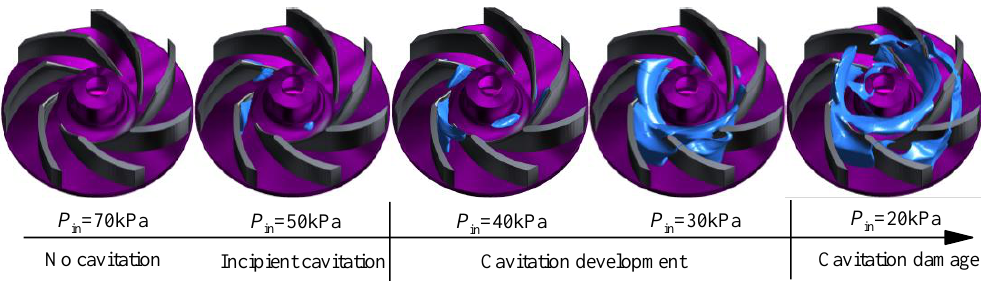
Figure 10. Cavitation formation process.